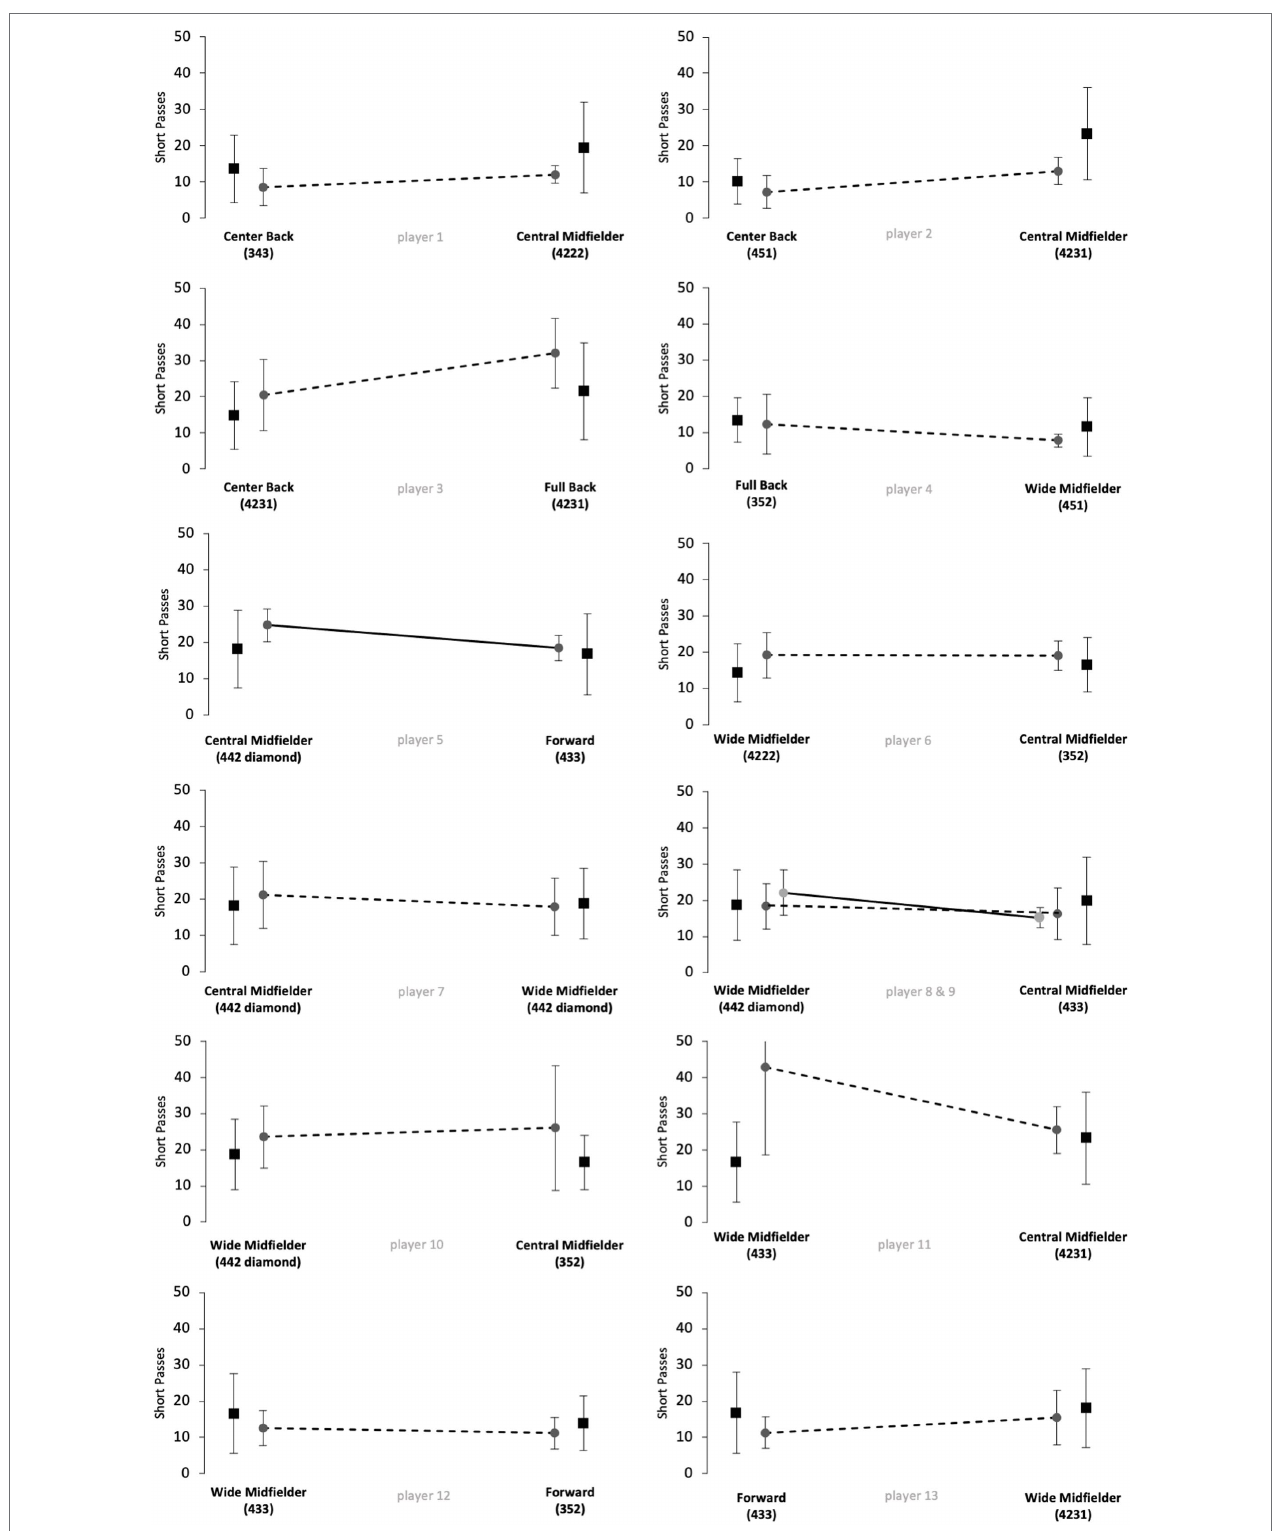
FIGURE 1 | Number of short passes of players from the study sample (grey circles) in relation to normative positional data (black squares). Data are presented as means ± SD for the respective games played on the respective positional role. Solid lines indicate significant differences in performance between the two positions for the respective